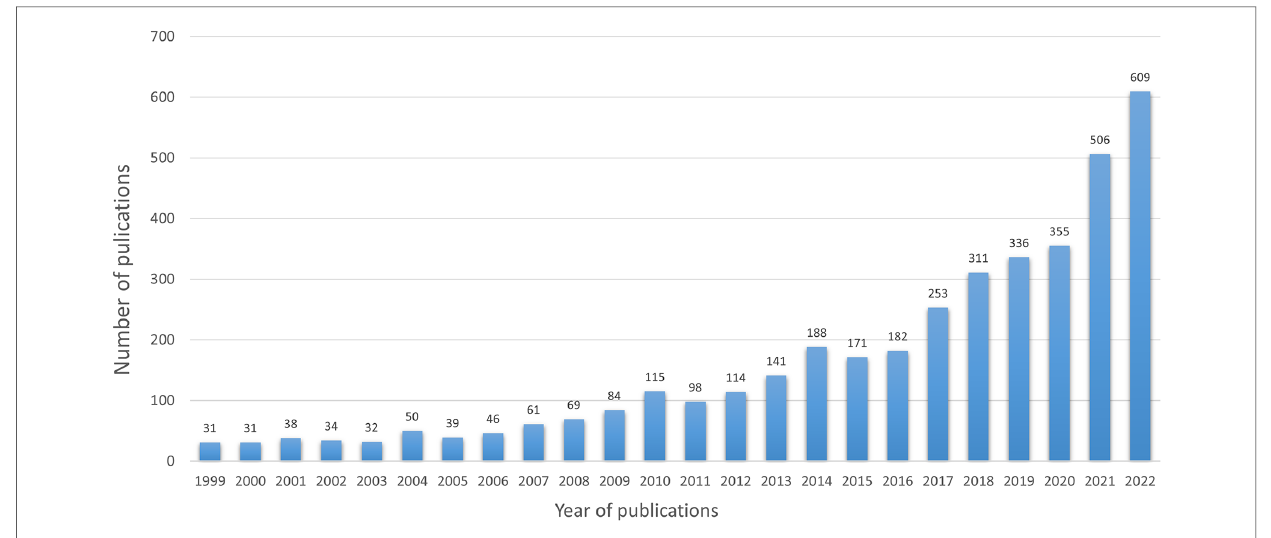
FIGURE 2 The number of articles per year from 1999 to 2022. The number of literature studies published has grown steadily and peaked in 2022.